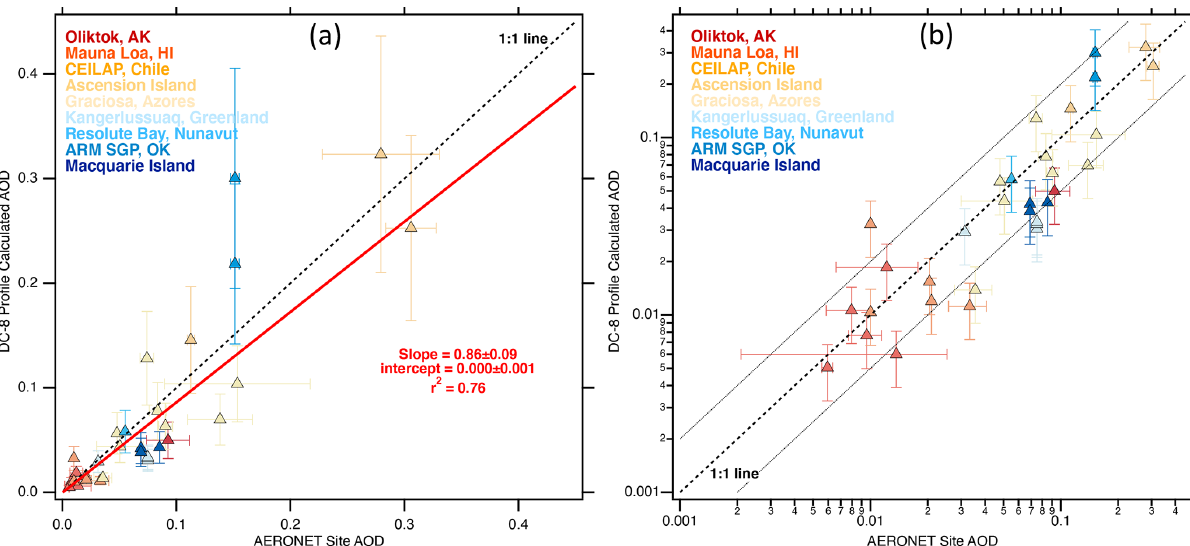
Figure 6. Aerosol optical depth (AOD) at 532nm calculated from the in situ aerosol measurements on the DC-8 as a function of AOD measured by AERONET sites within 300km and ± 4h of the profile. (a) Linear plot. Two-sided linear regression (red line) accounts for x and y uncertainties. (b) As in (a) , but a log–log plot. The dashed line is the 1:1 line, and dotted lines are a factor of 2 higher and lower. AERONET AOD at 532nm is interpolated from measurements at 500 and 670nm following Eq. (10). One outlier data point has been removed. Horizontal error bars indicate the variability in the AERONET AOD in ± 4h surrounding the measurement time. Vertical error bars indicate an approximate ± 30% uncertainty in the AOD derived from in situ measurements. Locations of the AERONET sites are given in Fig. 1.